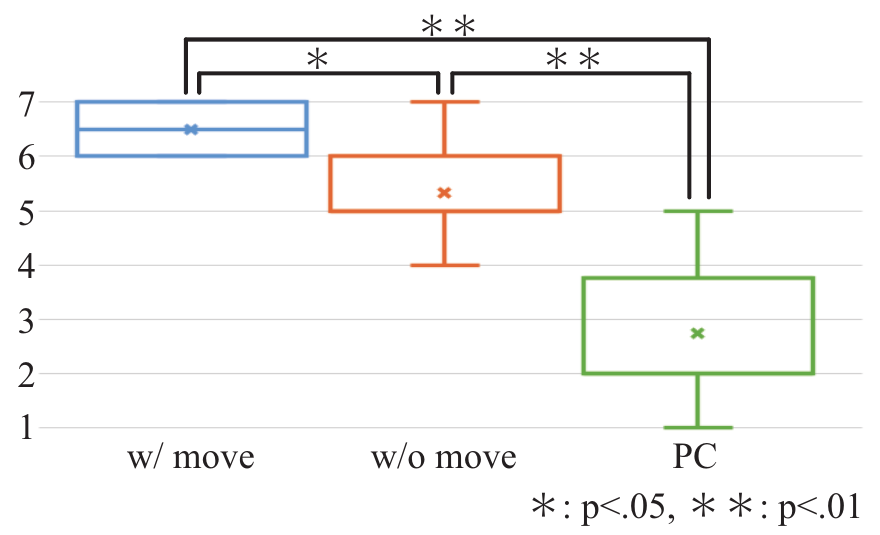
Figure 11. Results (“Did you feel that you actually walk at the zoo?”).